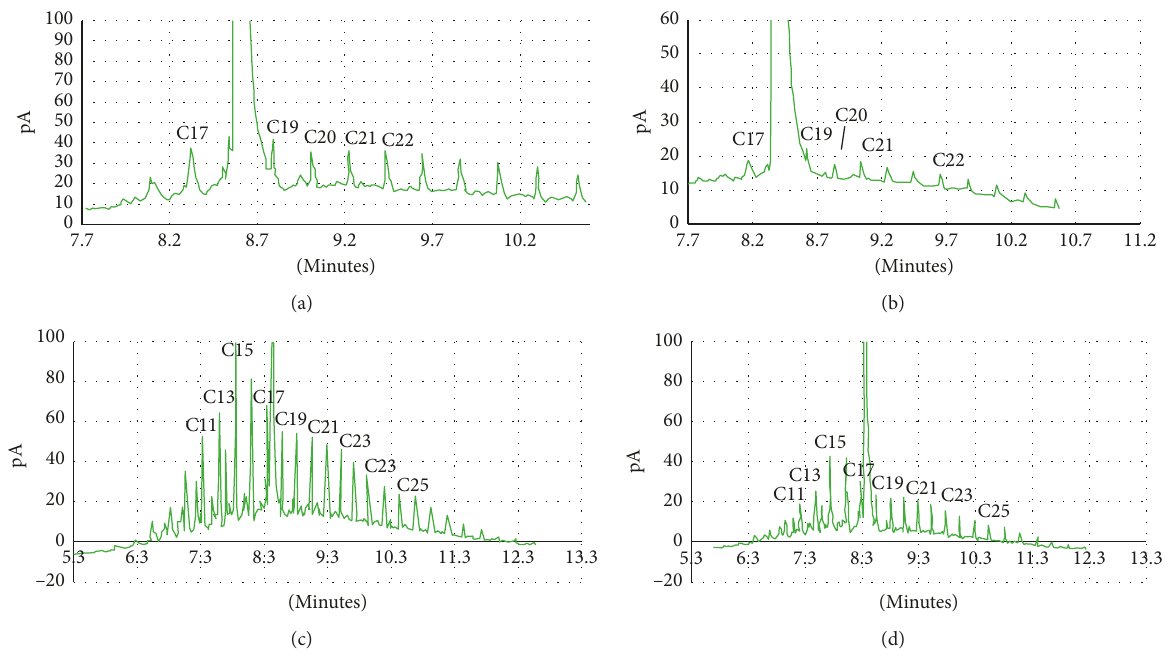
Figure 5: Chromatograms of THPs derivatives in water before and after treatment with vZVI: (a) initial concentration concentration 1.31 ppm, (c) initial concentration (cid:31)